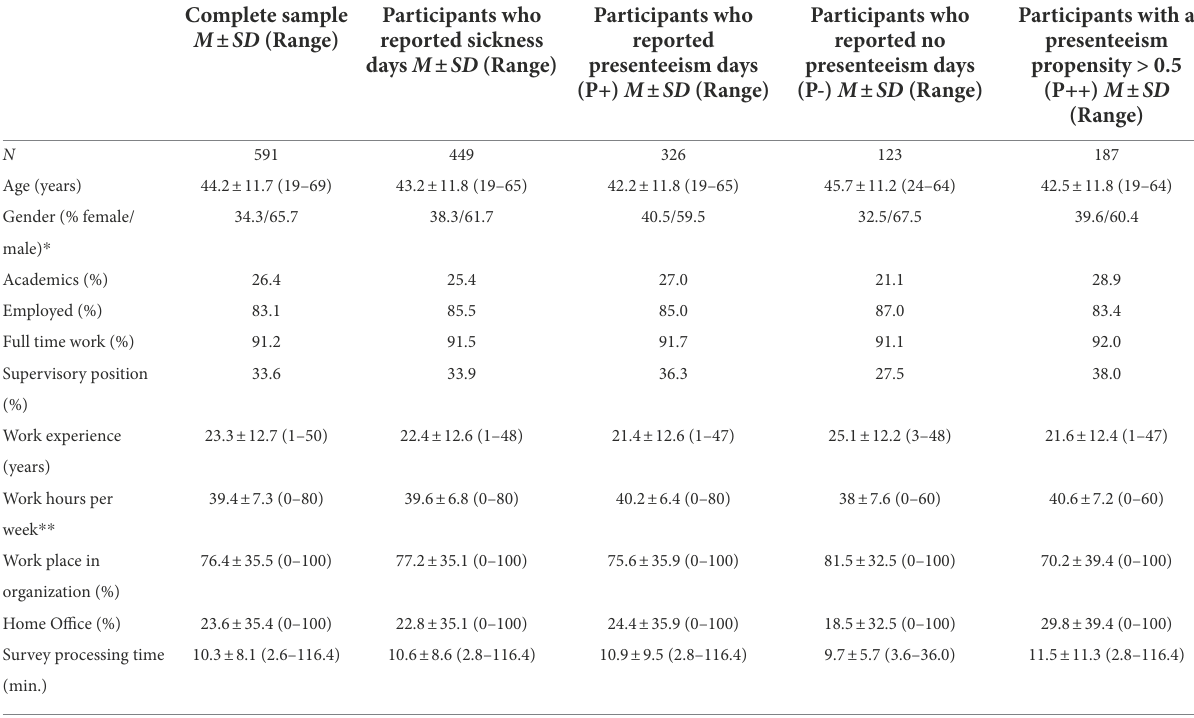
TABLE 2 Results of the descriptive analyses of demographic and employment-related characteristics of the study